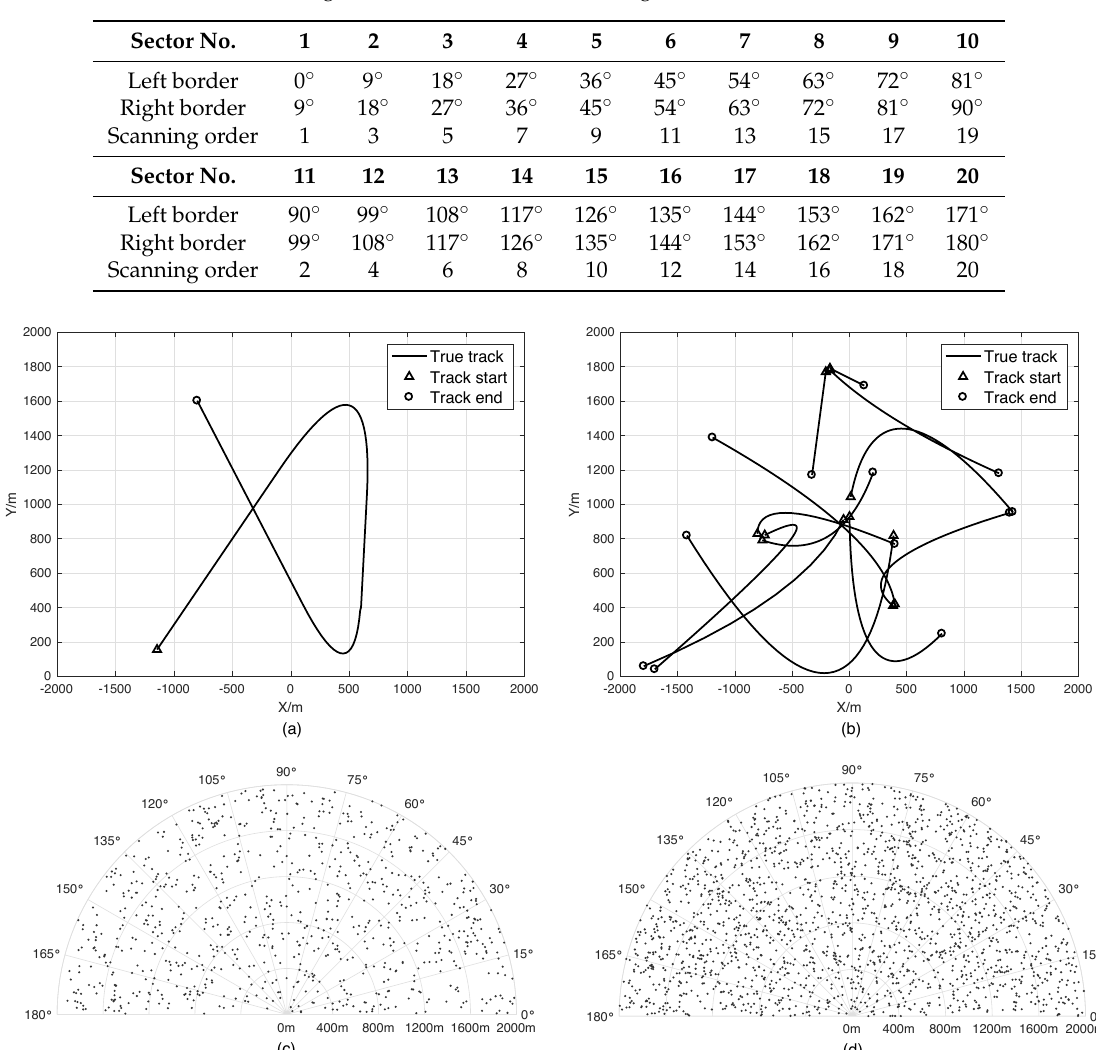
Table 1. Scanning order of the electronic scanning antenna in Scenarios 2 and 4.